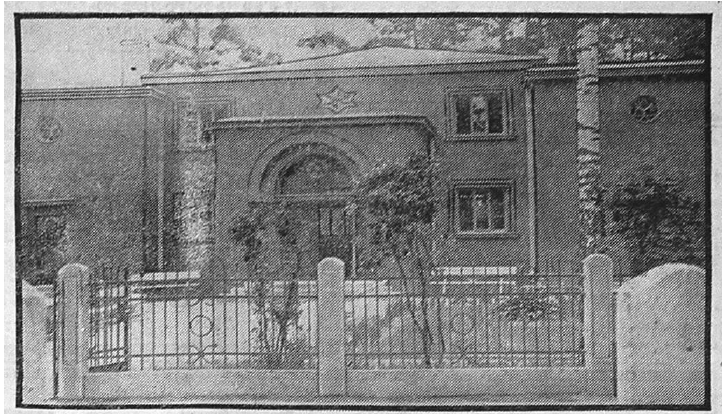
Figure 13. Majori Synagogue, view from the west ( Hajnt 1939a).